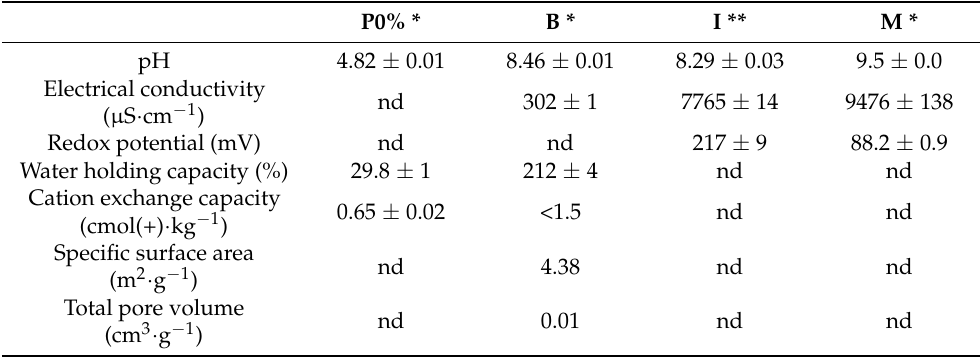
Table 1. Main physicochemical properties of Pontgibaud technosol (P0%) and the three used amend- ments: biochar (B), ochre (I), and manure (M). ( n = 3; nd = non